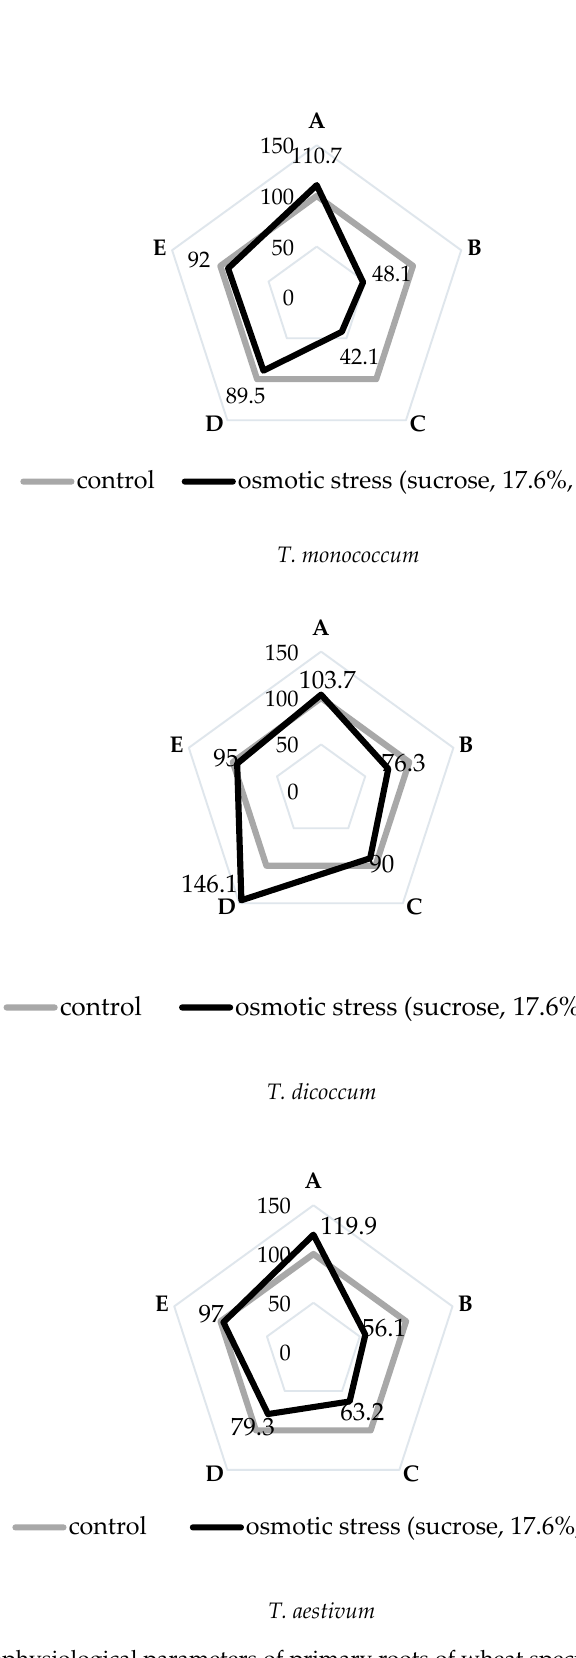
Figure 1. Morphophysiological parameters of primary roots of wheat species under induced water deficit. (A) root / shoot (length). (B) root relative water content. (C) root biomass. (D) root length. (E) number of roots.